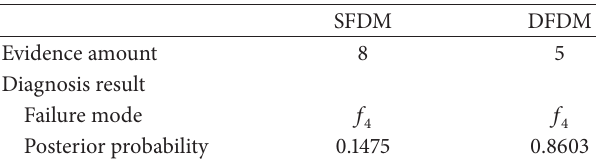
Table7:DiagnosisresultofstaticfaultdiagnosismechanisminCase Table 8: Diagnosis process comparison between SFDM and DFDM in Case